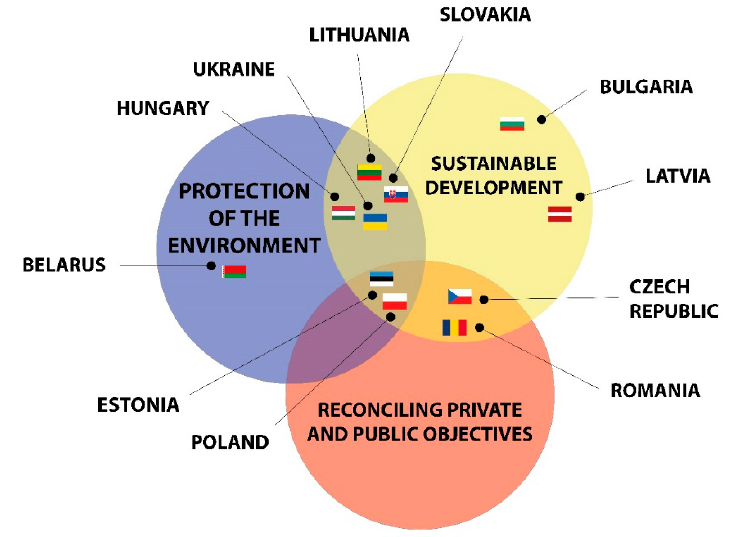
Figure 3. Most recurring values in the laws of the countries surveyed.